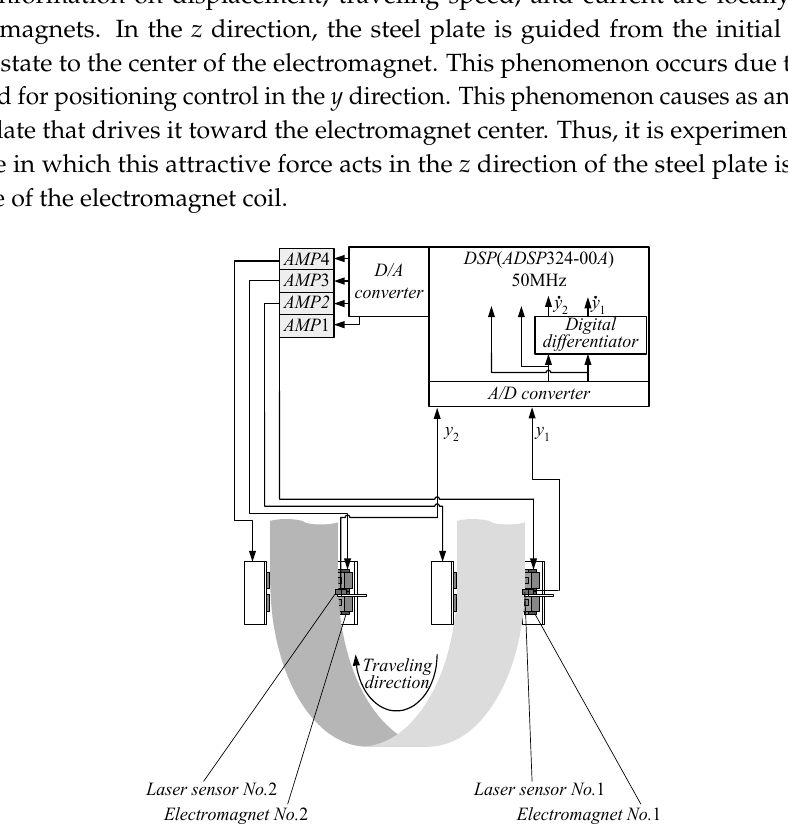
Laser sensor No. 1 Laser sensor No. 2